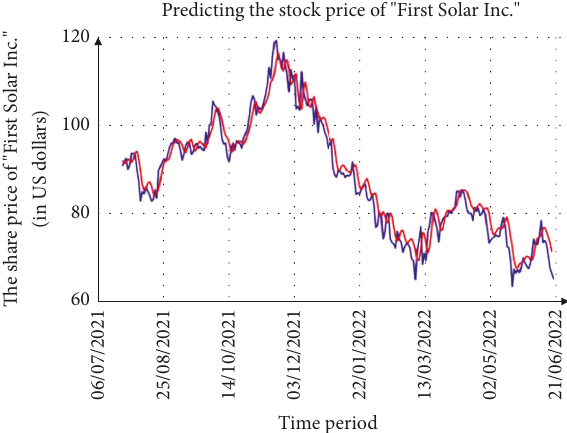
Figure 1: Predicting the stock price of First Solar Inc (The blue color shows the real stock price, red color shows projected stock price). Sources: authors.